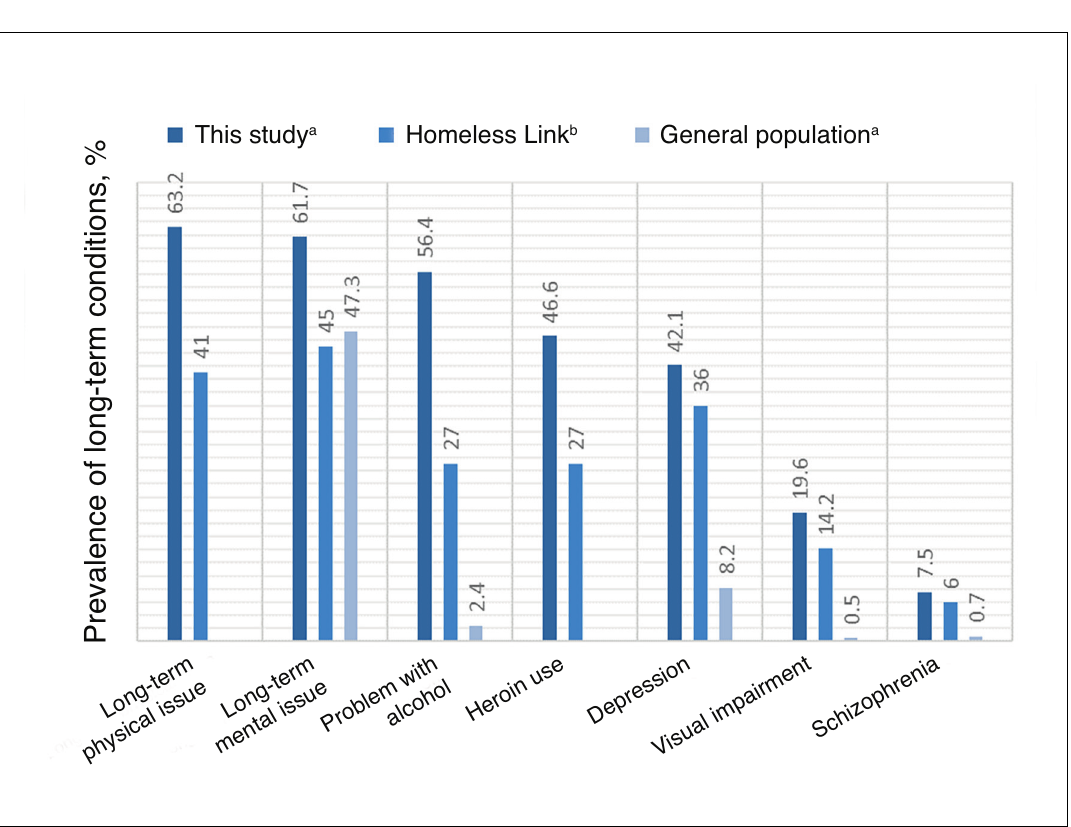
Figure 1. Prevalence of LTCs of high prevalence in homeless cohorts. 3,5,7 a Clinically recorded data. b Self-reported data. Figures for population- representative sample for long-term mental health problem are based on data for the socioeconomic class of greatest deprivation.